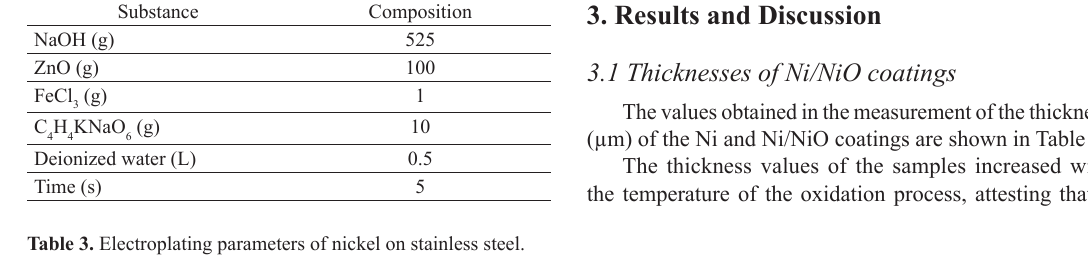
Table 3. Electroplating parameters of nickel on stainless steel.